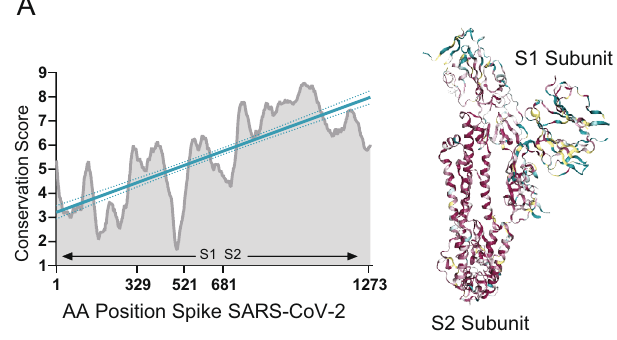
Fig. 2 Conservation of SARS-CoV-2 S protein. A Multiple sequence alignment was generated by the ConSurf algorithm (https://consurf.tau.ac.il) using the chain A of the SARS-CoV-2 spike protein in the closed state (PDB ID 6VXX) as a reference. Amino acid conservation scores were classi fi ed into nine levels. Structure of the SARS-CoV-2 S protein (chain A) with amino acid residues colored according to conservation on a scale from green (1, most variable) to dark purple (9, most conserved) is also